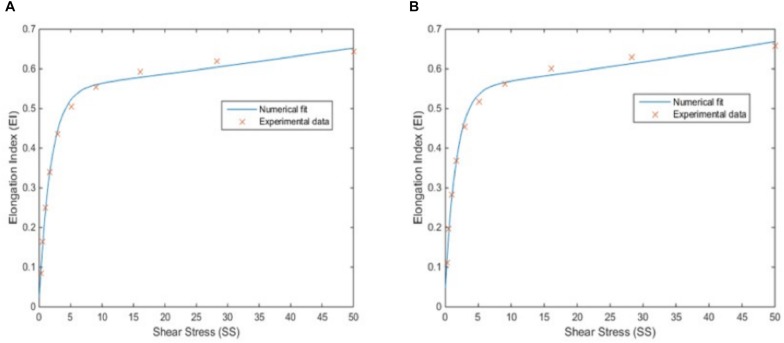
Correlation between elongation index (EI) and shear stress (SS). EI-SS correlation for oxygenated blood samples with a 2-element exponential fit, for which R2 is 0.9952 (p < 0.05) (A) and for deoxygenated blood samples with a 2-element exponential fit, for which R2 is 0.9940 (p < 0.05) (B).